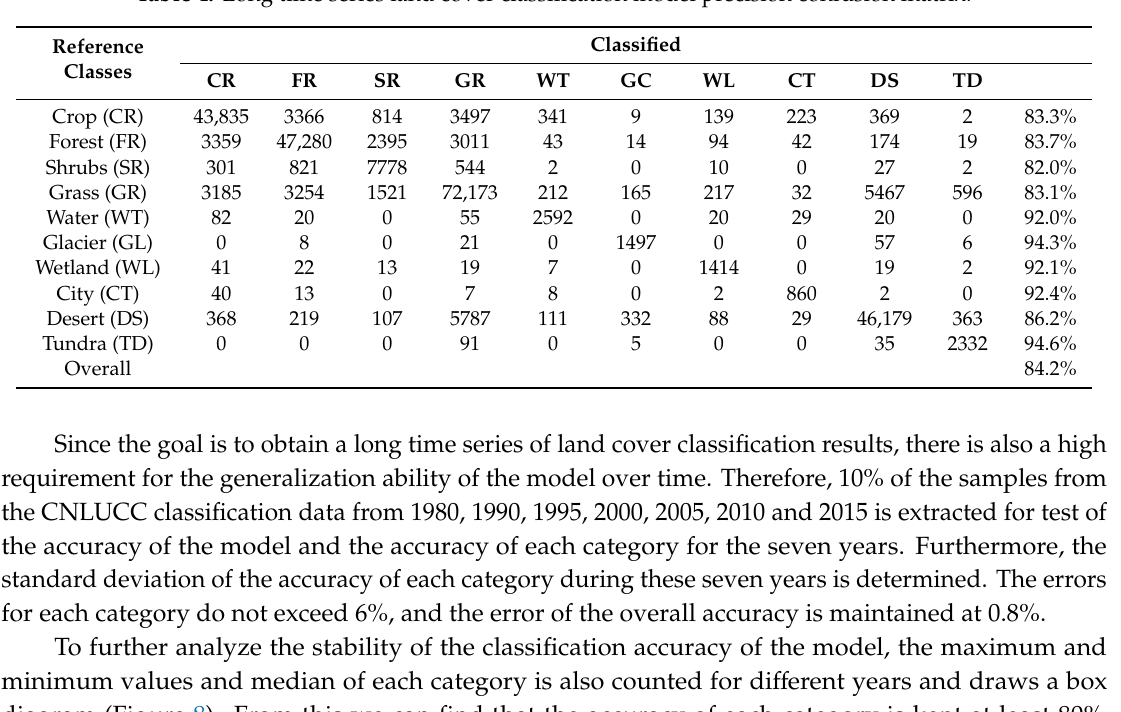
Table 5. Land cover percentage grading accuracy for 2010. Level 0